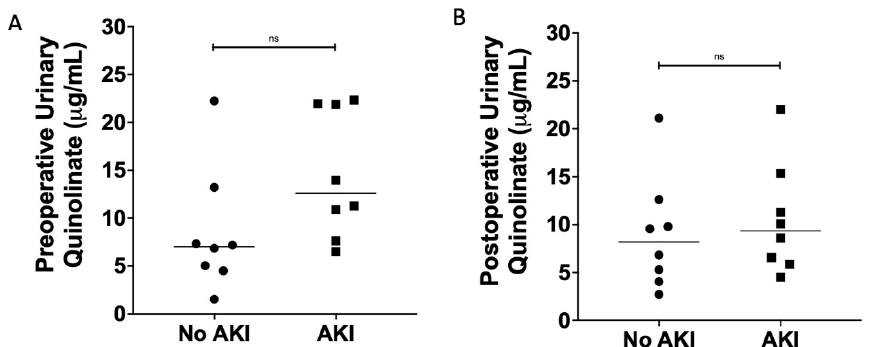
Figure 1. Urinary quinolinate concentrations for patients with and without postoperative AKI: ( A ) preoperative quinolinate concentration and ( B ) postoperative quinolinate concentration. ns denotes non-significant difference.